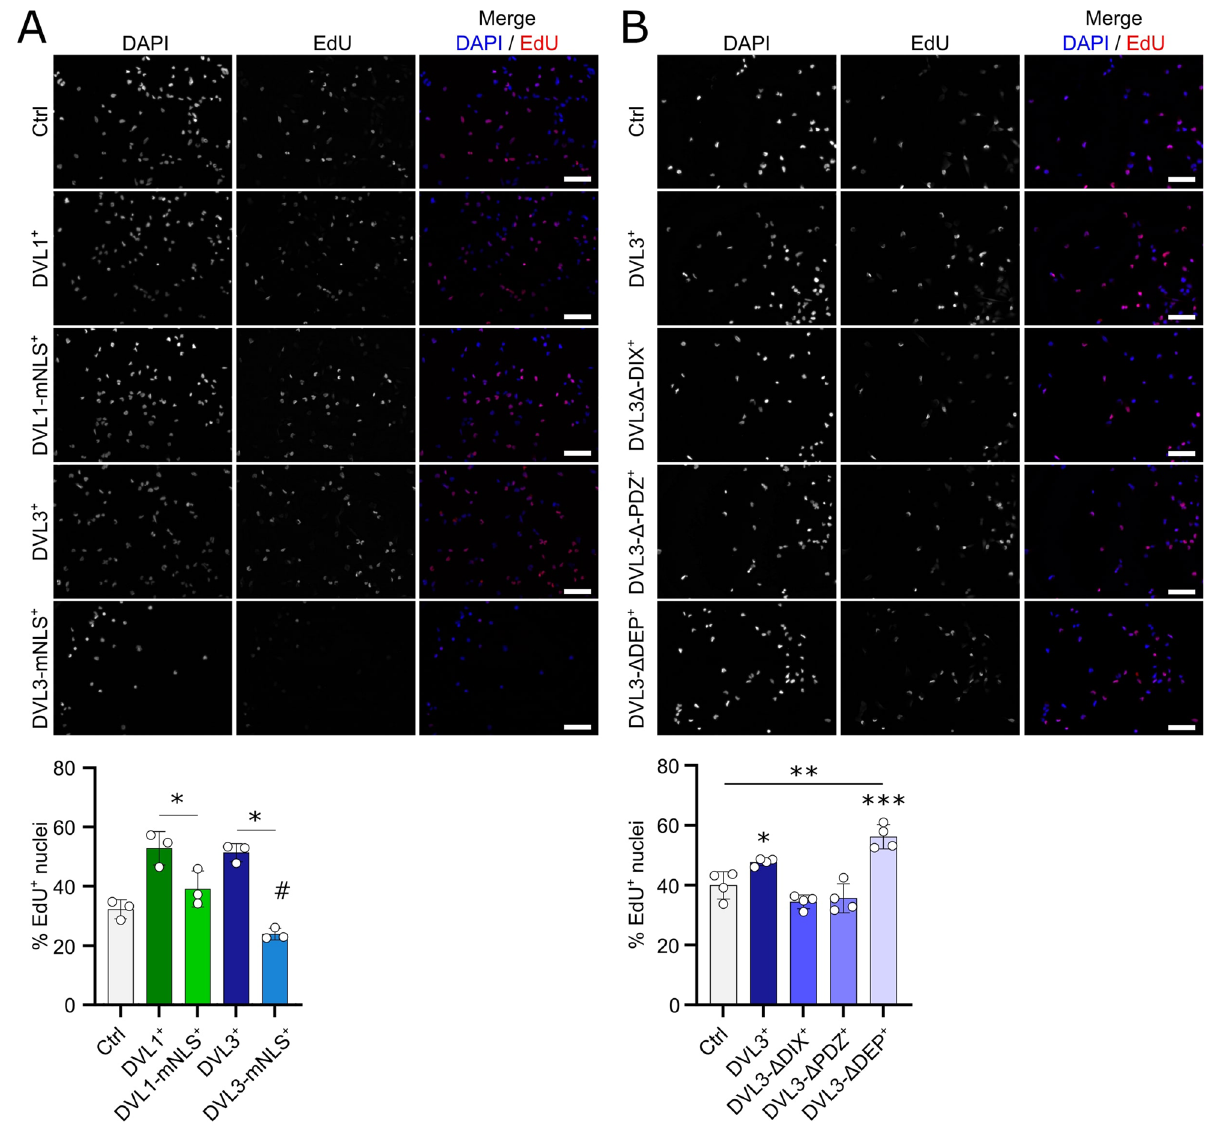
Figure 9. DVL1 and DVL3 require nuclear localisation to enhance proliferation in ARMS cells. ( A ) Representative images of stable proliferating DVL1 + , DVL1-mNLS + , DVL3 + , DVL3-mNLS + and control (pUltra) RH30 ARMS cells with incorporated EdU (red) and a DAPI nuclear counterstained (blue). Scale bar represents 100 µm. Quantification was performed for 3 biological replicates, and a significant difference was calculated using a student’s T-test, where an asterisk denotes p < 0.05 comparing the two groups connected with a line and # denotes p < 0.05 compared to control. ( B ) Representative images of proliferating DVL3 + , DVL3-ΔDIX + , DVL3-ΔPDZ + , DVL3-ΔDEP + or control (pUltra) RH30 cells with EdU incorporation visualised (red) and a DAPI nuclear counterstained (blue). Scale bar represents 100 µm. Quantification was performed for 4 biological replicates, and significant difference calculated using a One-Way ANOVA, comparing each group against the control, where an asterisk denotes p < 0.05, and three asterisks denotes p < membrane recruitment of DVL 59 , which likely explains why deletion of the DEP domain did not alter DVL3 function. Therefore, DVL3 regulates myoblast proliferation via its nuclear localisation and likely ability to then propagate canonical WNT signalling via its DIX or PDZ domains. In contrast to DVL3, provided that DVL1 is able to enter the nucleus, mutations of either the DIX, PDZ or DEP domains have no effects on its ability to enhance the proliferation rate in myoblasts. Thus, while manipula- tion of DVL3 or DVL1 led to the same biological outcome in myoblasts, they employ different mechanism. Two acetylated lysine residues in the PDZ and DIX domain of DVL1 also promote nuclear localisation (in addition to the NLS) and promoter binding 60 . If those residues can compensate for each other, then deletion of both amino acids/domains would be required to inhibit the pro-proliferative effect of DVL1 overexpression. In DVL3, lysine residues do not occupy these two positions, which may explain the different mechanism of action.